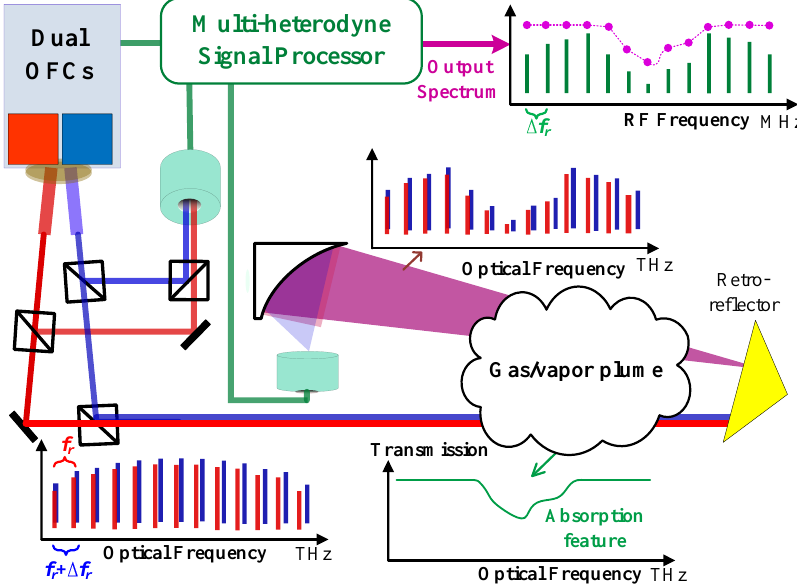
ff gas sensing through dual-comb